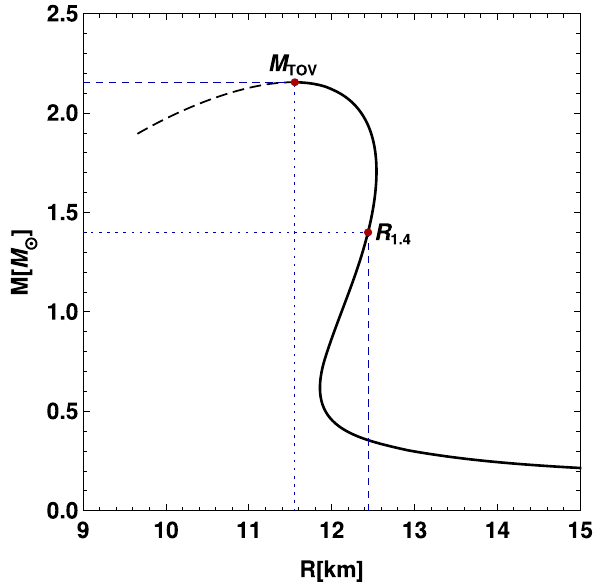
Fig. 3 An example of a mass-radius curve for neutron stars. The solid (dashed) black curve is the stable (unstable) branch. I also mark the maximum mass M TOV of (nonrotating) stars and the radius R 1 . 4 at M = 1 . 4 M